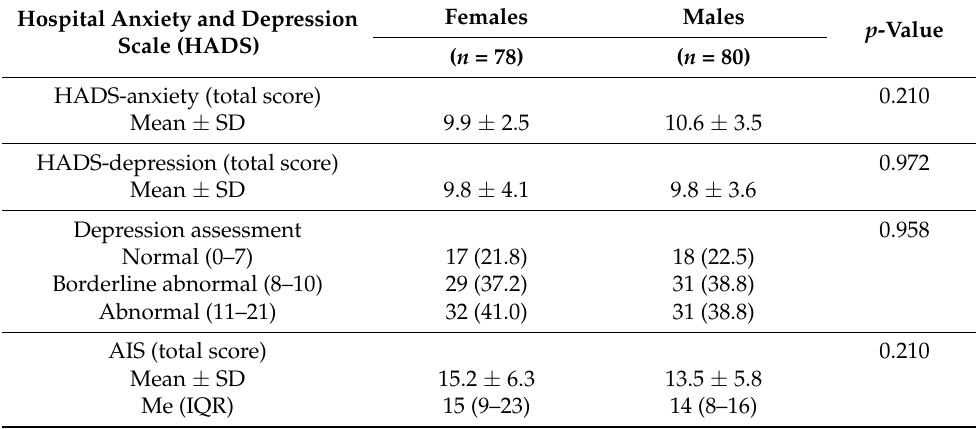
Table 3. Assessment of depression and anxiety symptoms and sleep disturbance in men and women using the hospital anxiety and depression scale (HADS) questionnaire and the Athens insomnia scale